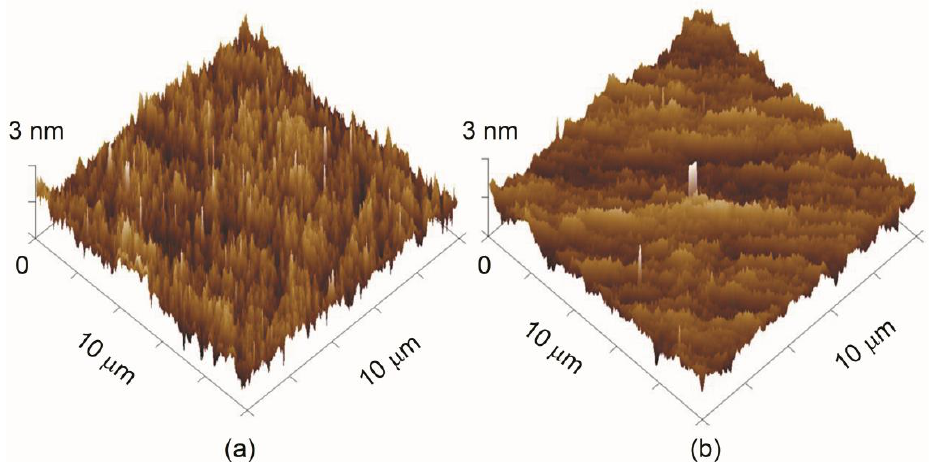
Figure 3. Three-dimensional AFM surface images of Cr film with thicknesses of 3 nm ( a ) and 5 nm ( b